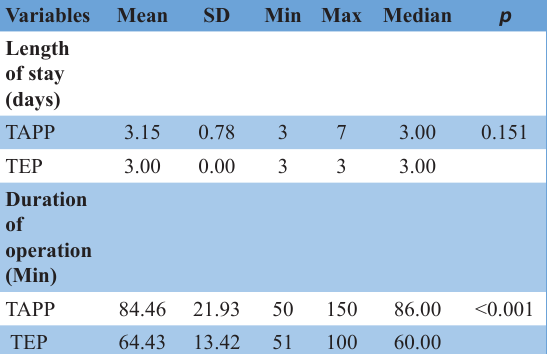
Table 3. Length of hospital stay and duration of operation in TAPP and TEP